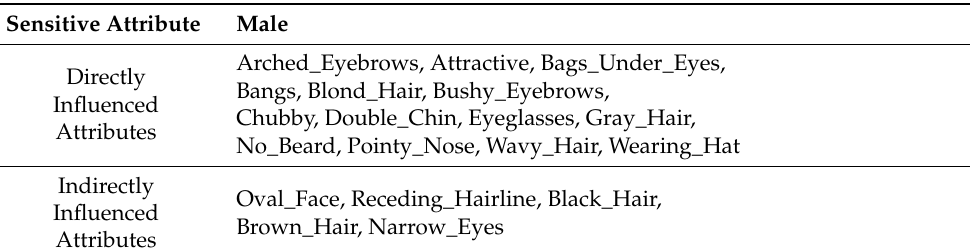
Table 1. Influenced attributes by gender in the